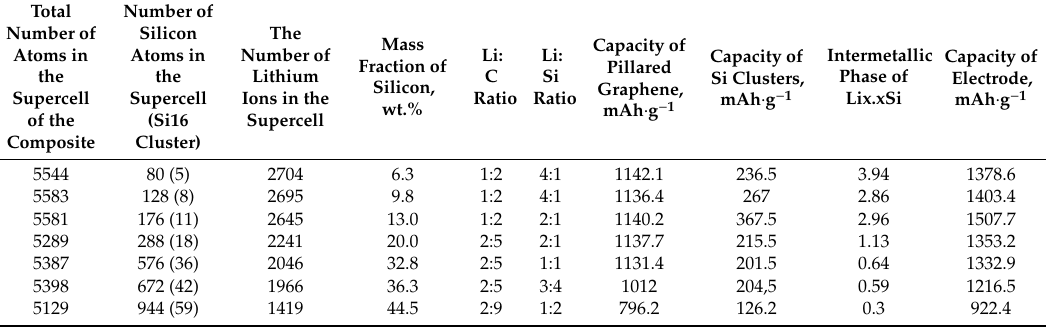
Table 1. Parameters of model I as the battery anode material.